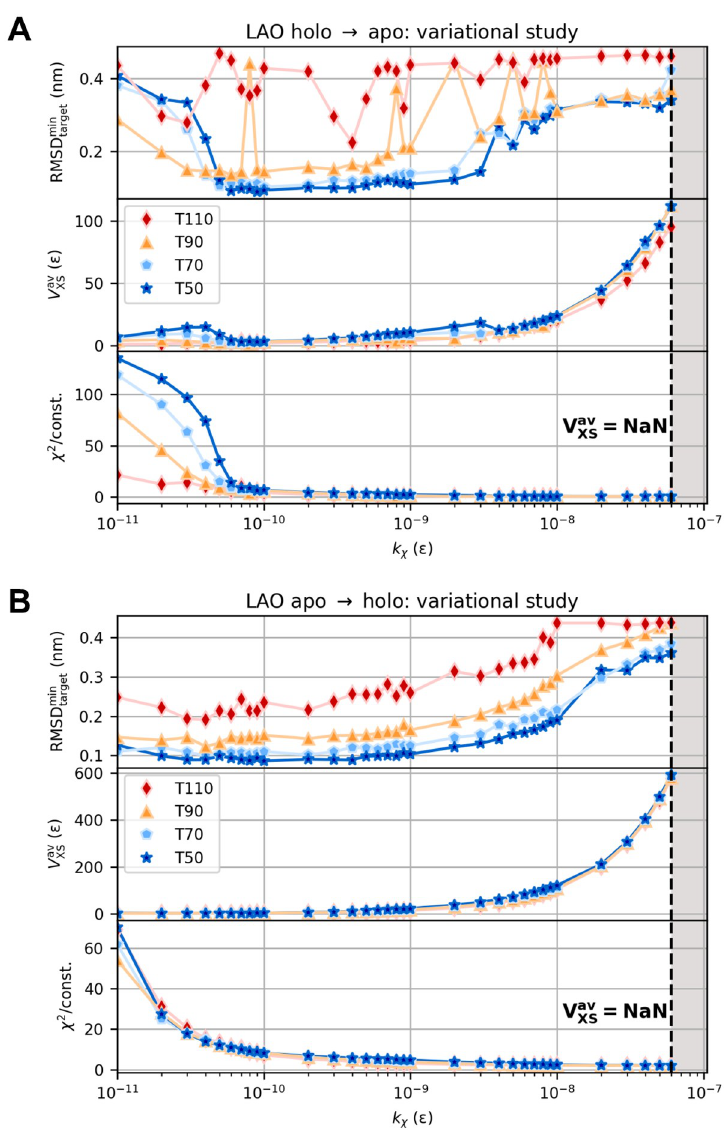
Fig 9. Variational study for LAO protein. Minimum target RMSD, average bias energy, and average χ 2 dissimilarity for holo-to-apo (A) and apo-to-holo (B) transition as a function of coupling strength k χ at different temperatures T . The variational series comprised 296 simulations in